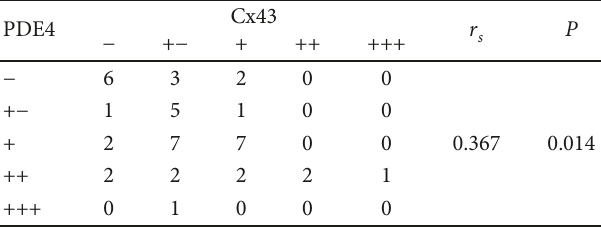
Table 4: Correlation between PDE4 and Cx43 protein levels in rectal cancer. PDE4